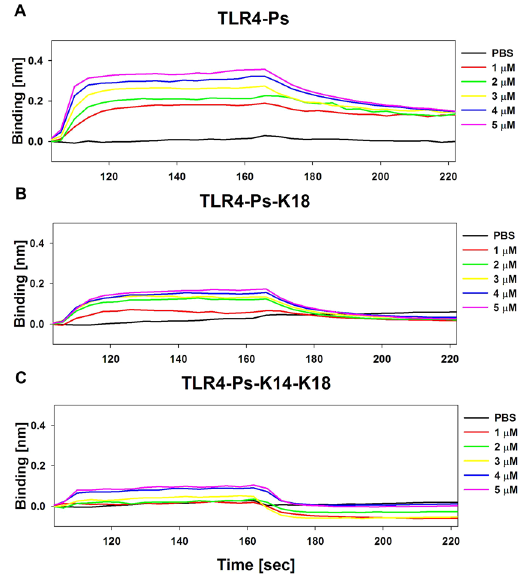
Figure 7. Binding between TLR4 and ( A ) Ps, ( B ) Ps-K18 and ( C ) Ps-K14-K18, as measured by bio-layer interferometry